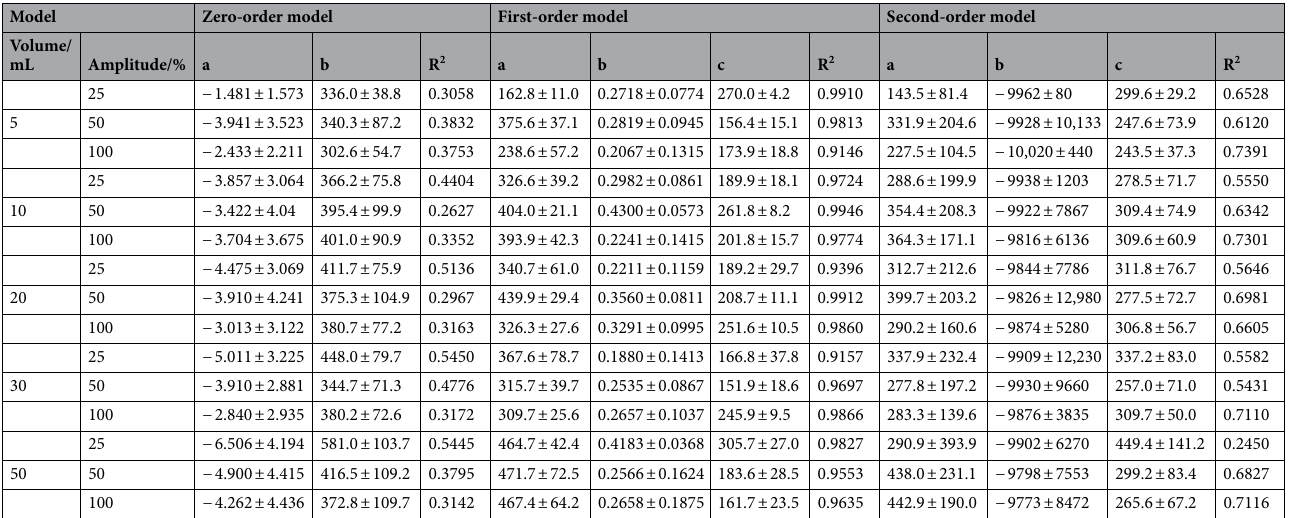
Table 2. Parameters of the three mathematical models